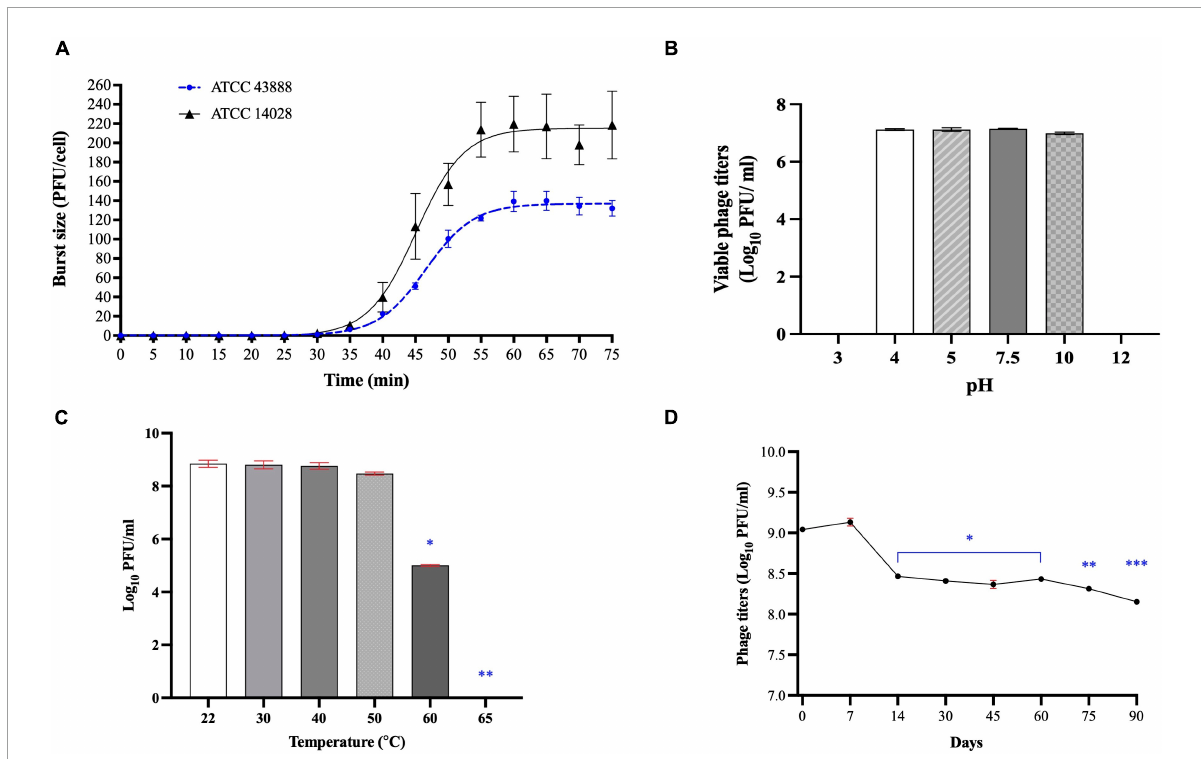
FIGURE5 Biological characteristics of phage Sa157lw, including one-step growth curve on both E. coli O157:H7 ATCC 43888 and Salmonella Typhimurium ATCC 14028 (A) , various pH stability at 25 ◦ C for 24 h (B) , temperature stability for 24 h (C) , and refrigeration storage at 4 ◦ C for 90 days (D) . For stability tests, means of phage titers that contain different numbers of asterisks differ ( P < 0.05). The error bars show the